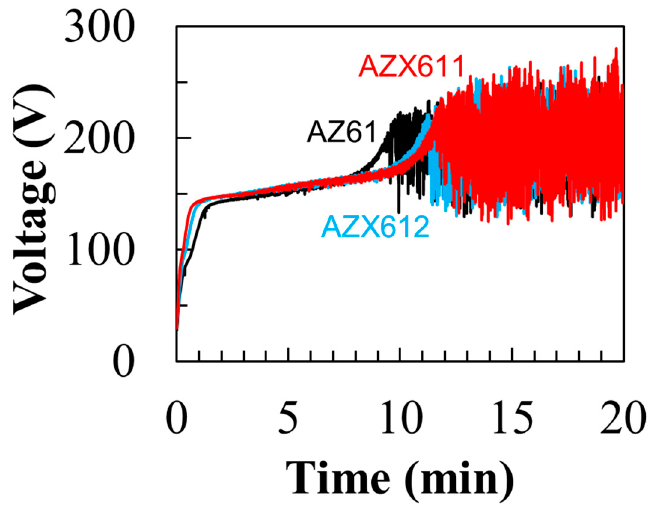
Figure 3. Voltage–time curves during 20 min anodization of AZ61, AZX611, and AZX612 alloys in 0.5 M Na 3 PO 4 solution at 25 ° C.